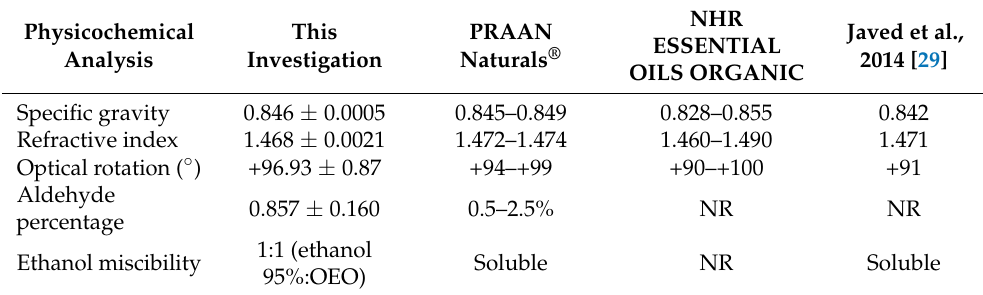
Table 1. Physicochemical characterization of OEO and comparison with other reference values. Physicochemical This Analysis